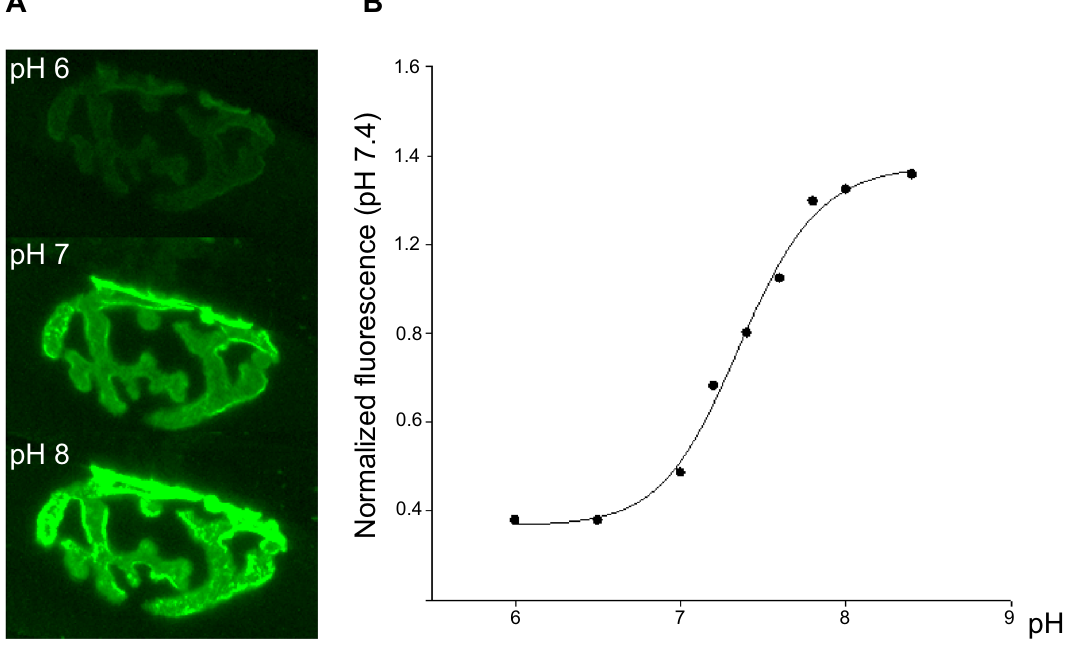
Figure 2. A The fluorescence image shows the NMJ incubated with SEP-BTX fusion protein bathed with 10 mM HEPES saline buffered at pH 6, 7, and 8. B Calibration curve (average of n = 3) obtained by measuring the fluorescence intensity of the NMJ incubated at different pHs. The value at pH 6 and 9 were considered the minimal and maximal fluorescence outputs, respectively (for calibration curve, see main